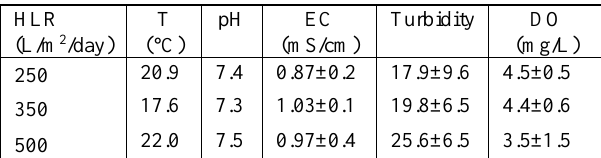
Figure 4. Trend of BOD 5 according to HLRs